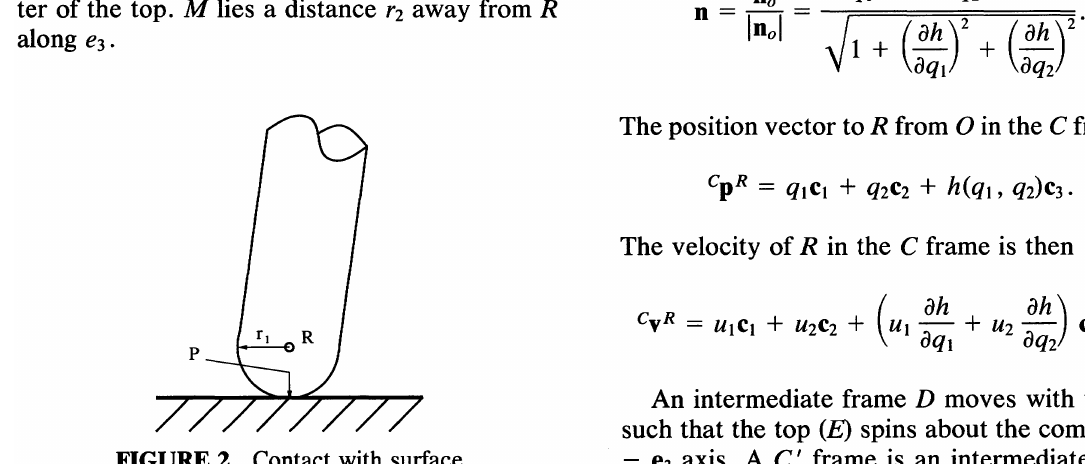
FIGURE 2 Contact with surface.